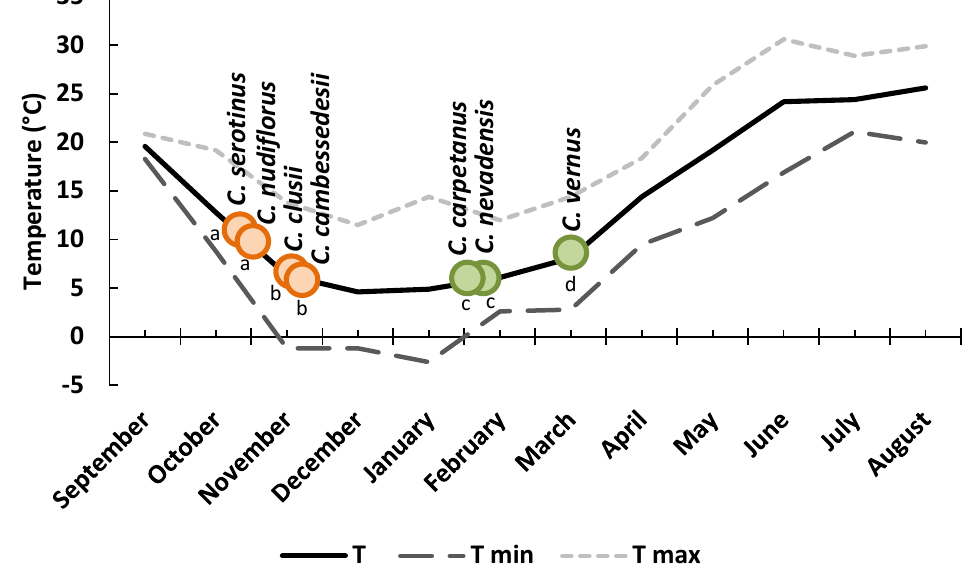
Figure 3. Flowering time of 112 accessions of seven crocus species under the same environmental conditions at the Bank of Plant Germplasm of Cuenca. Different letters indicate significant differences ( p < 0.05) among